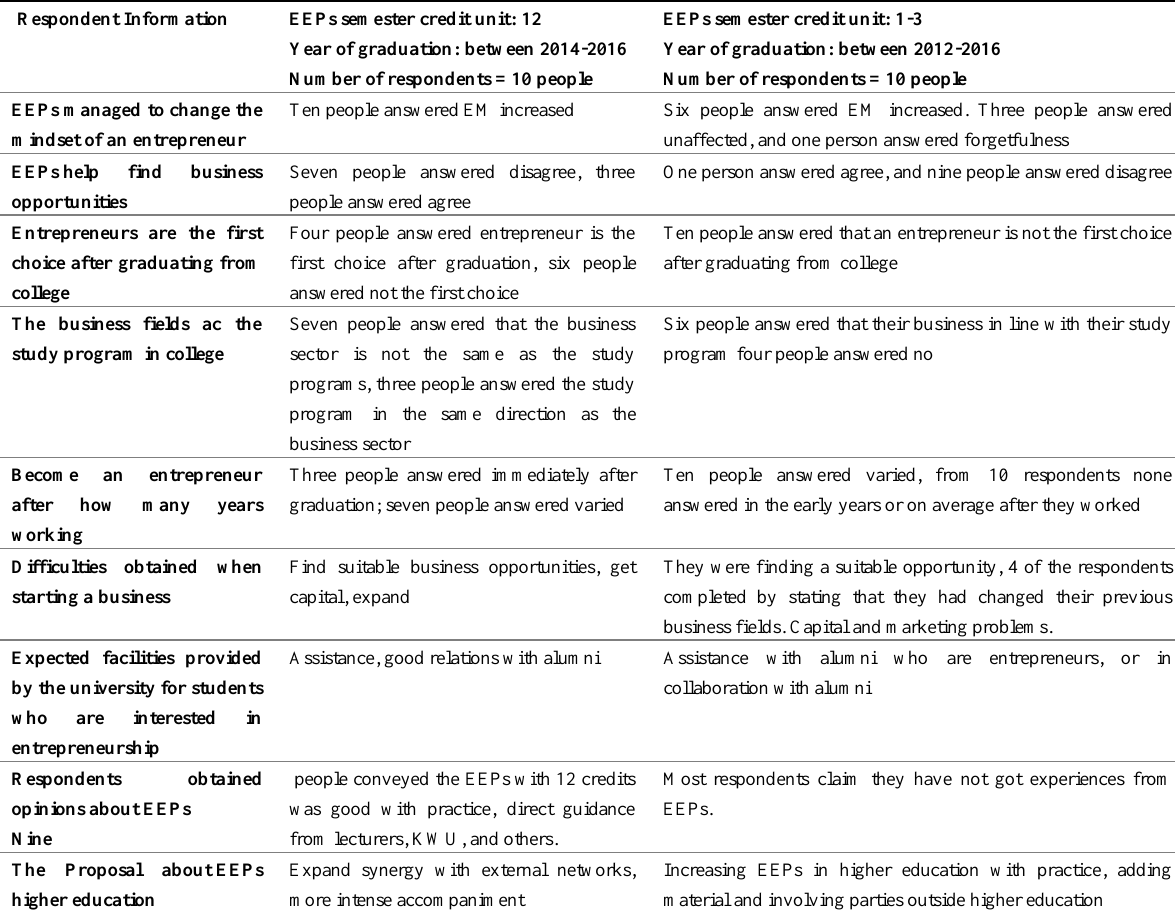
Table 1: Summary of interview